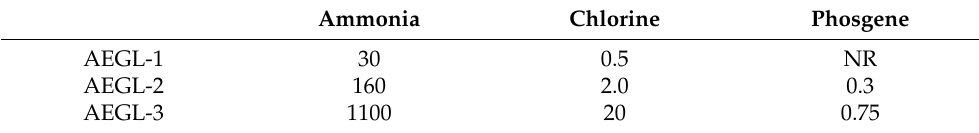
Table 1. Ammonia, chlorine, and phosgene, 1 h exposure duration. Results—AEGL Program. Ammonia Chlorine